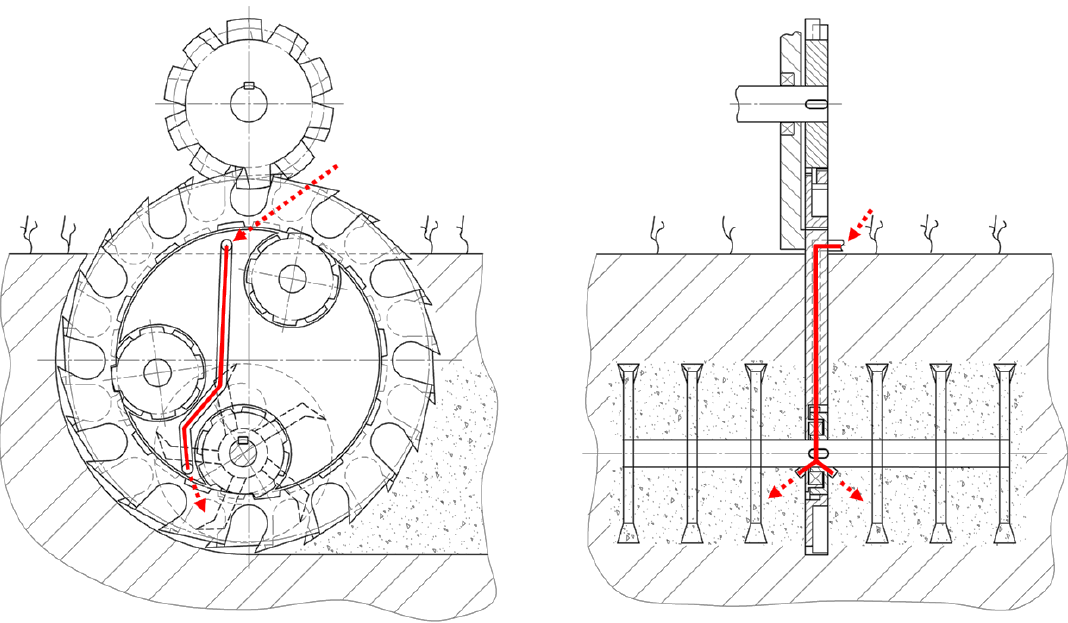
Figure 7. Intra-soil waste